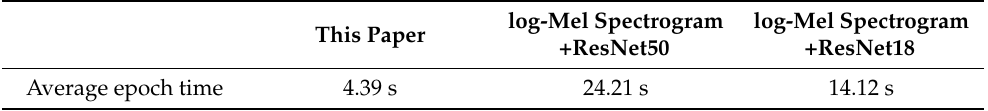
Table 5. Average epoch time for different